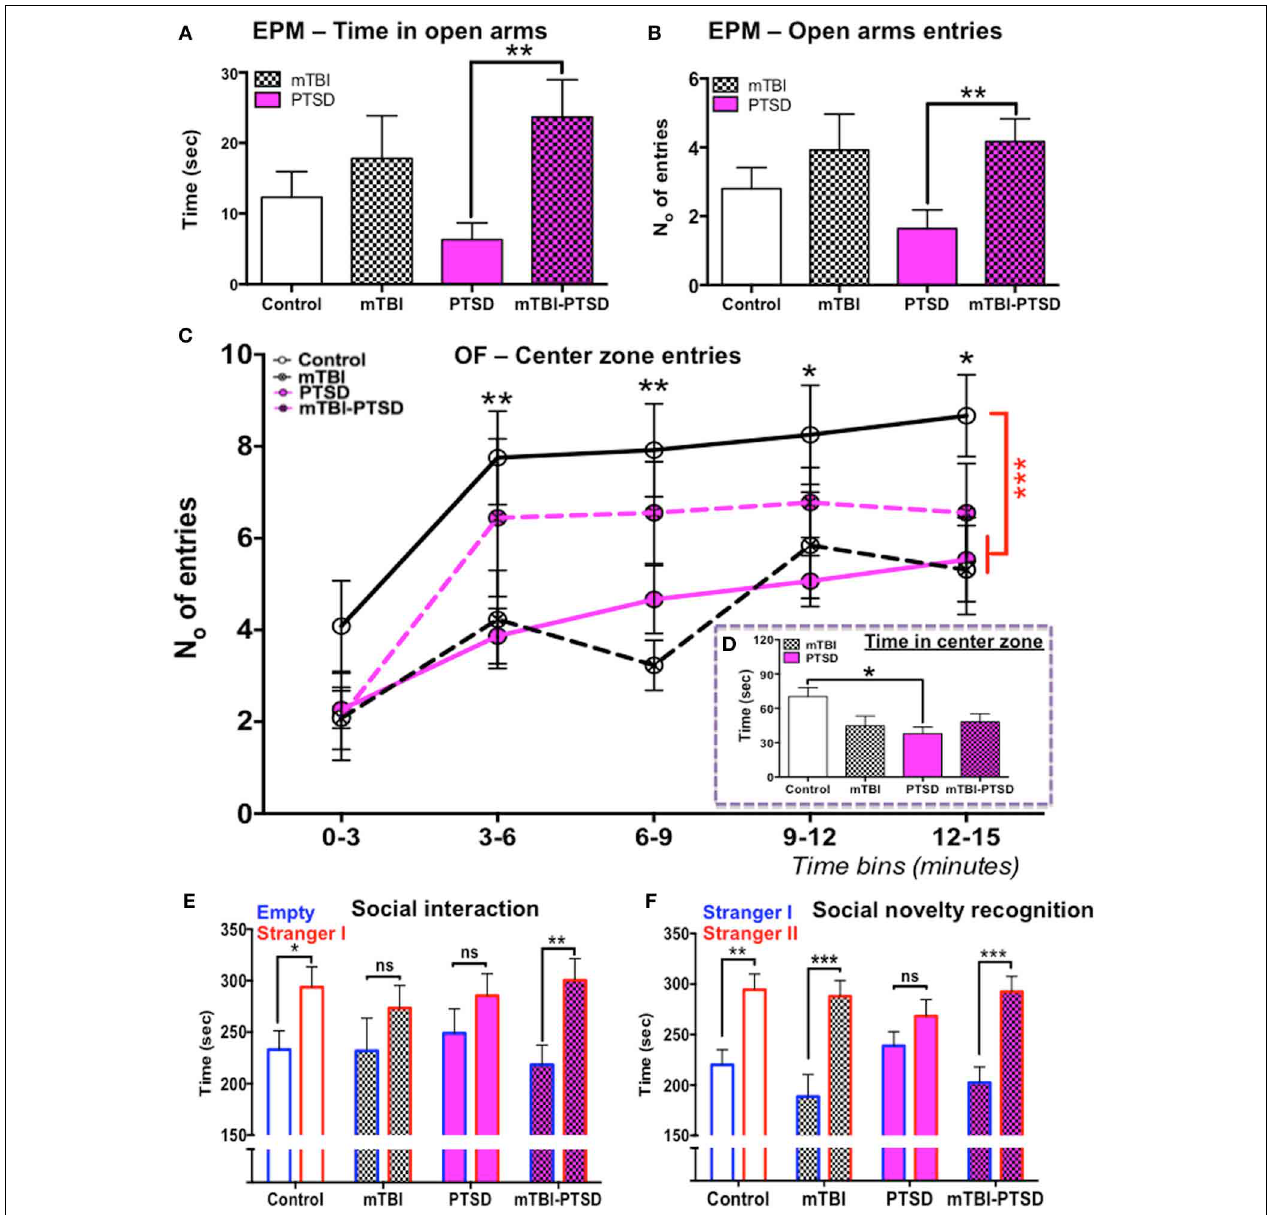
FIGURE 3 | Elevated plus maze, open-field, and social behavior. Elevated plus maze; PTSD only group spent 50% less time on average in the open arms compared to control, however this trend was not significant ( P > 0 . 05) following multiple comparisons test (A) . Animals that received mTBI spent relatively more time and number of entries into the open arm compared to control and PTSD only groups (A,B) . This comparison was shown to be statistically significant between the PTSD and mTBI-PTSD groups ( P < 0 . 05). Data in (A,B) were analyzed using non-parametric Kruskal Wallis-One Way ANOVA followed by Dunn’s correction for multiple testing. Open field test demonstrated a statistically significant reduction in mean center zone entries over the 15min trial ( P < 0 . 01) in both mTBI and PTSD animals compared to control (C) . However there was a noticeable trend in the behavior of mTBI-PTSD animals, compared to PTSD only and mTBI only animals. The latter showed an increased mean number of entries into the center zone, although this was not statistically significant ( P > 0 . 05) compared to the other groups (C) . Only the PTSD group showed a significant reduction in the mean total time spent in the center zone over the 15-min trial compared to